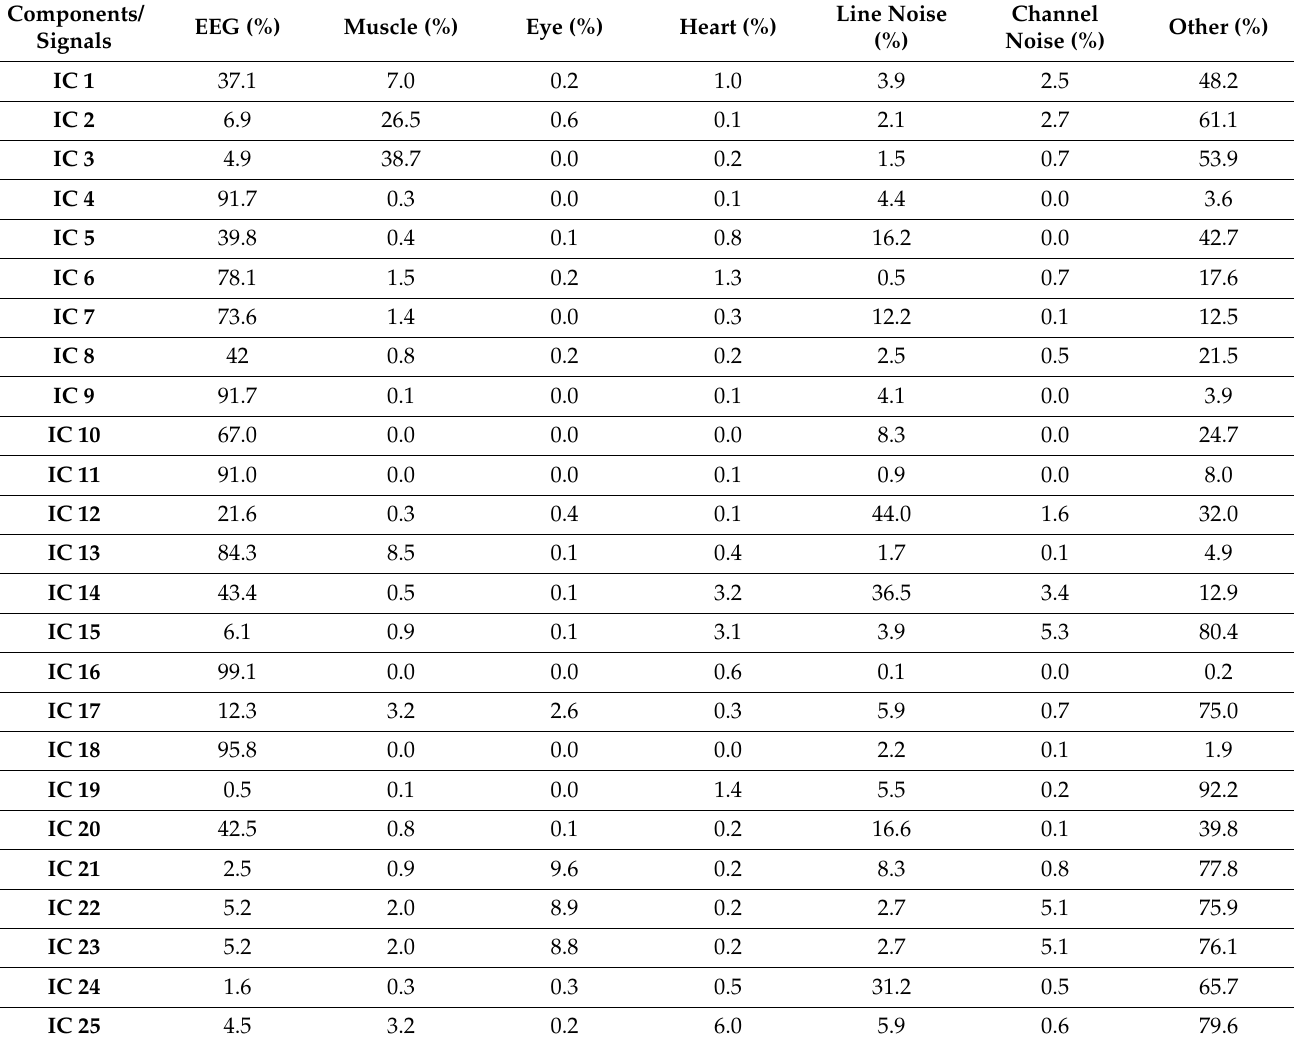
Table 1. EEG and artifacts present in the observed